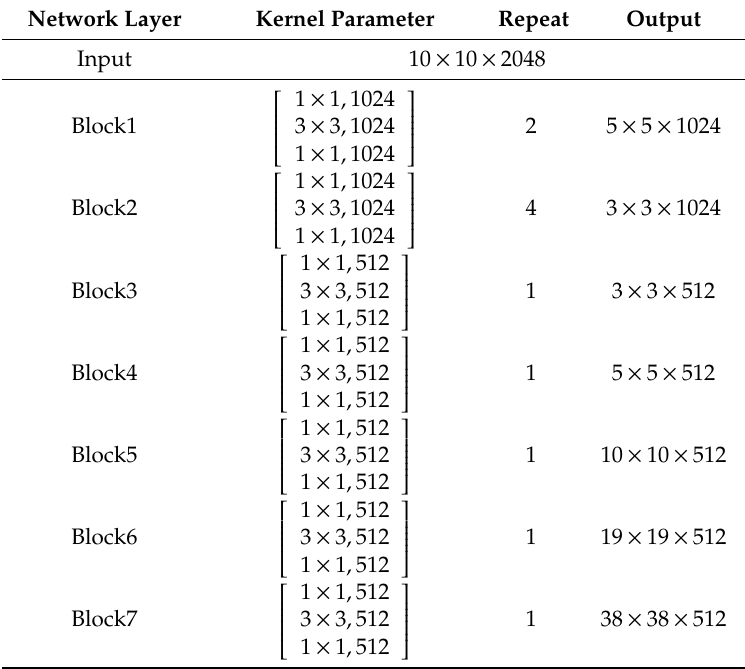
Table 1. Detailed parameters of hourglass